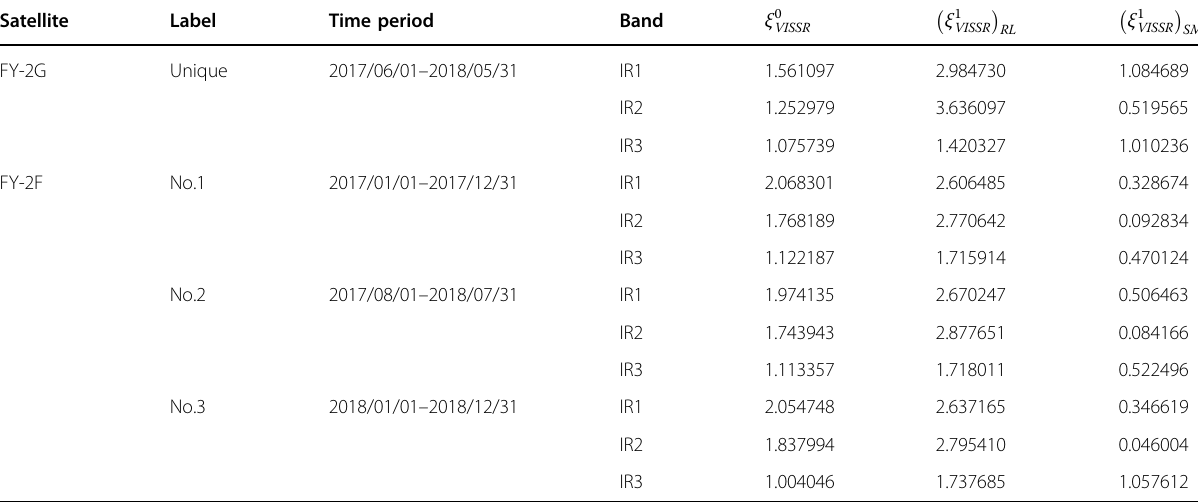
Table 1 Main SIRC coef fi cients for IR1 – IR3 bands of both FY-2G and FY-2F satellites with the intercalibrated results during different time periods